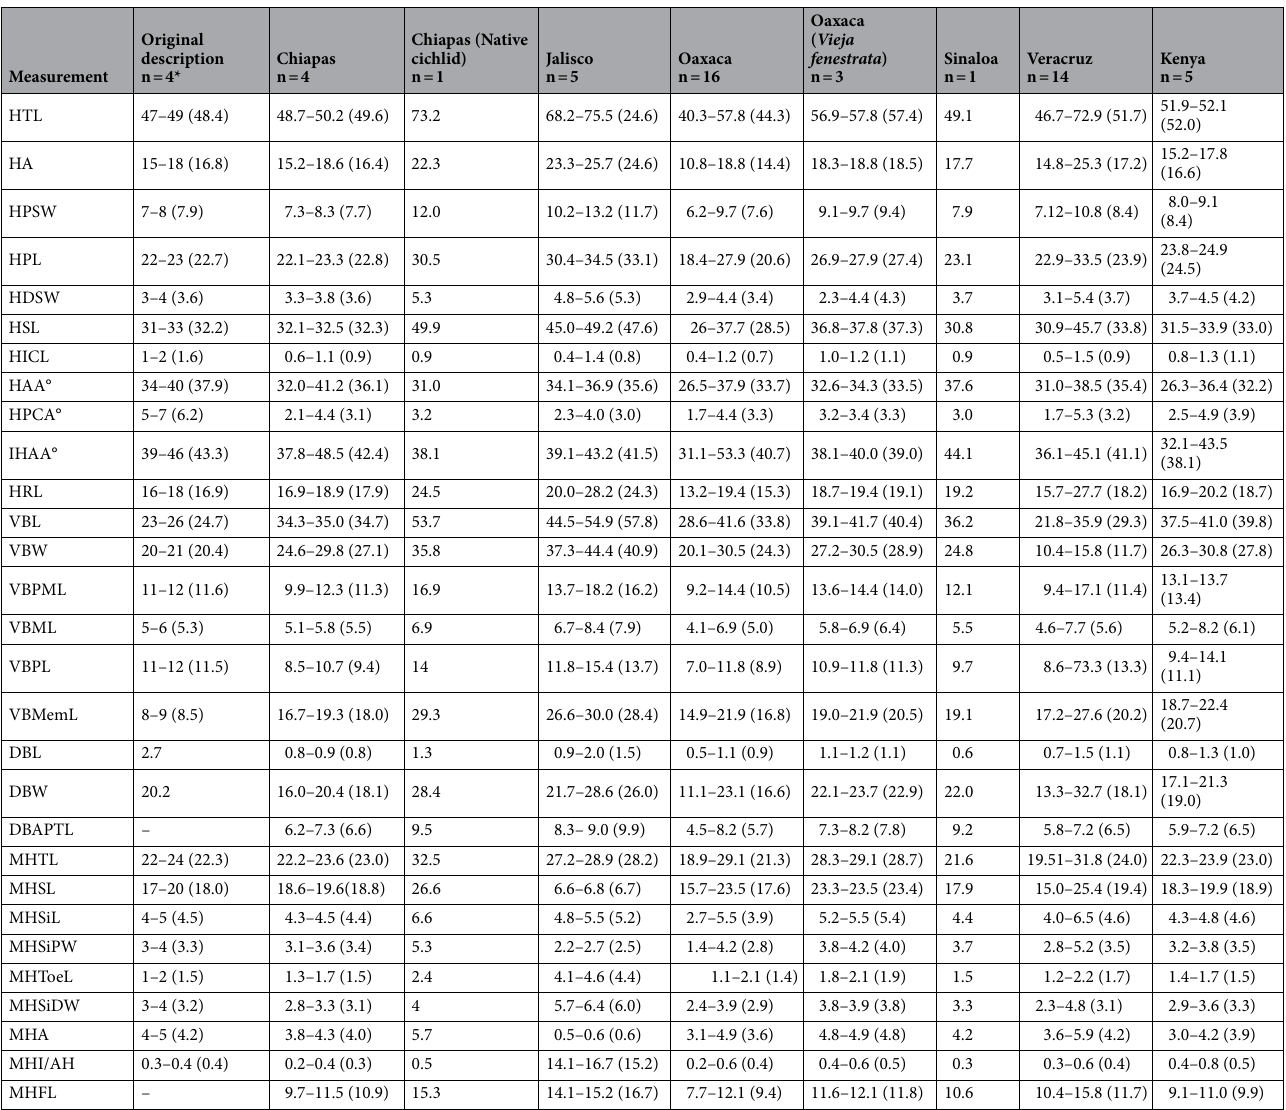
Table 3. Measurements of Gyrodactylus yacatli García-Vásquez, Hansen, Christison, Bron & Shinn, 2011 compared with specimens found in the Mexican states of Chiapas, Jalisco, Oaxaca and Veracruz infecting cultured “tilapias” and native cichlids, and specimens from cultured Oreochromis niloticus from Kenya, Africa. HTL hamulus total length; HA Hamulus aperture; HPSW hamulus point shaft width; HPL Hamulus point length; HDSW Hamulus distal shaft width; HSL Hamulus shaft length; HICL Hamulus inner curve length; HAA° Hamulus aperture angle; HPCA° Hamulus point curve angle; IHAA° Inner hamulus aperture angle;